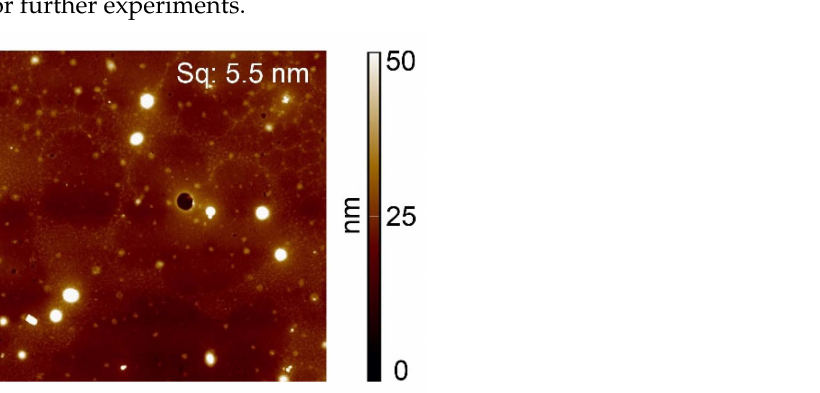
Figure 4. AFM images of polystyrene after loading with copper(II). The edge length of all AFM images is 10 µ m. Polystyrene surface exposed to 0.1 M Cu(ac) 2 in ethanol/NH 3 solution, surface roughness Sq = 5.5 nm.